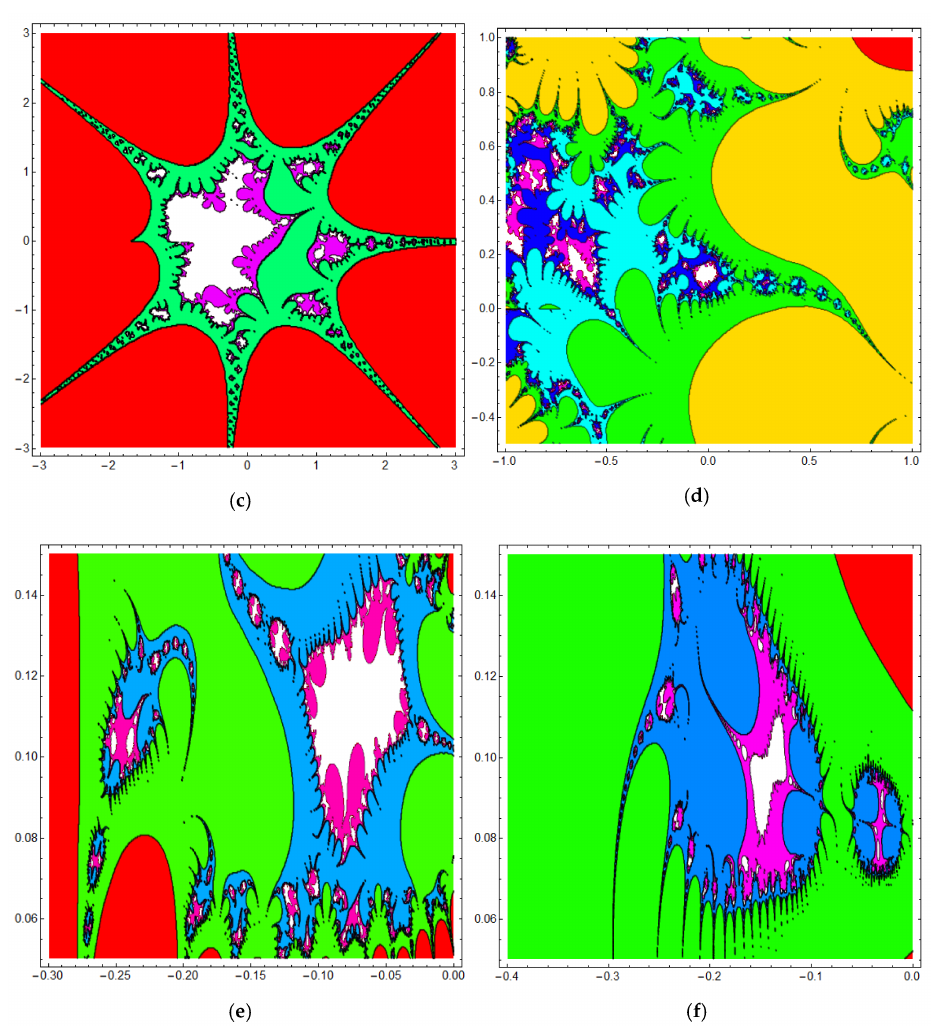
Figure 9. ( a – c ) The Julia sets generated by the generalized fractional cosine map at α = 0.5 and q = 0.41 + 0.65 i , where ( a ) p = 1, ( b ) p = 2, ( c ) p = 3.8. ( d – f ) The values of the parameters are α = 0.5 and q = − 0.1 − 0.7 i , where ( d ) p = 5.3, ( e ) p = 7, ( f ) p =